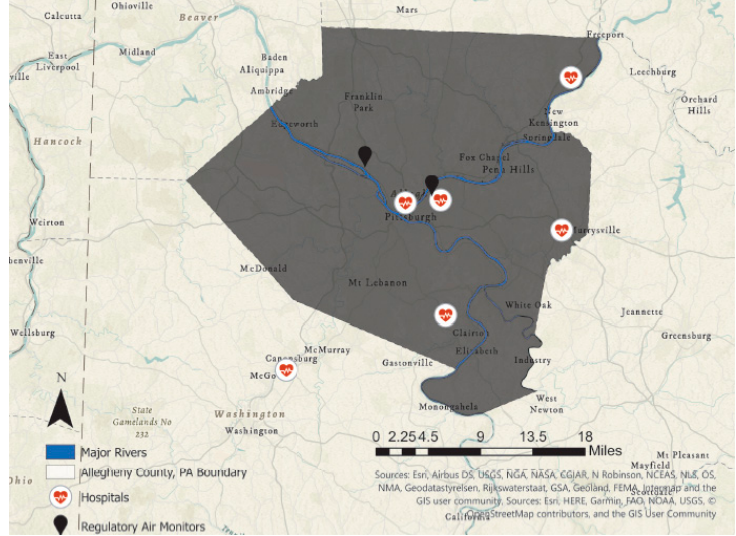
Figure 1. Map of Allegheny County, PA, depicting locations of regulatory air monitors and hospitals where asthma-related Emergency Department (ED) visits were recorded between 2008 and 2013.